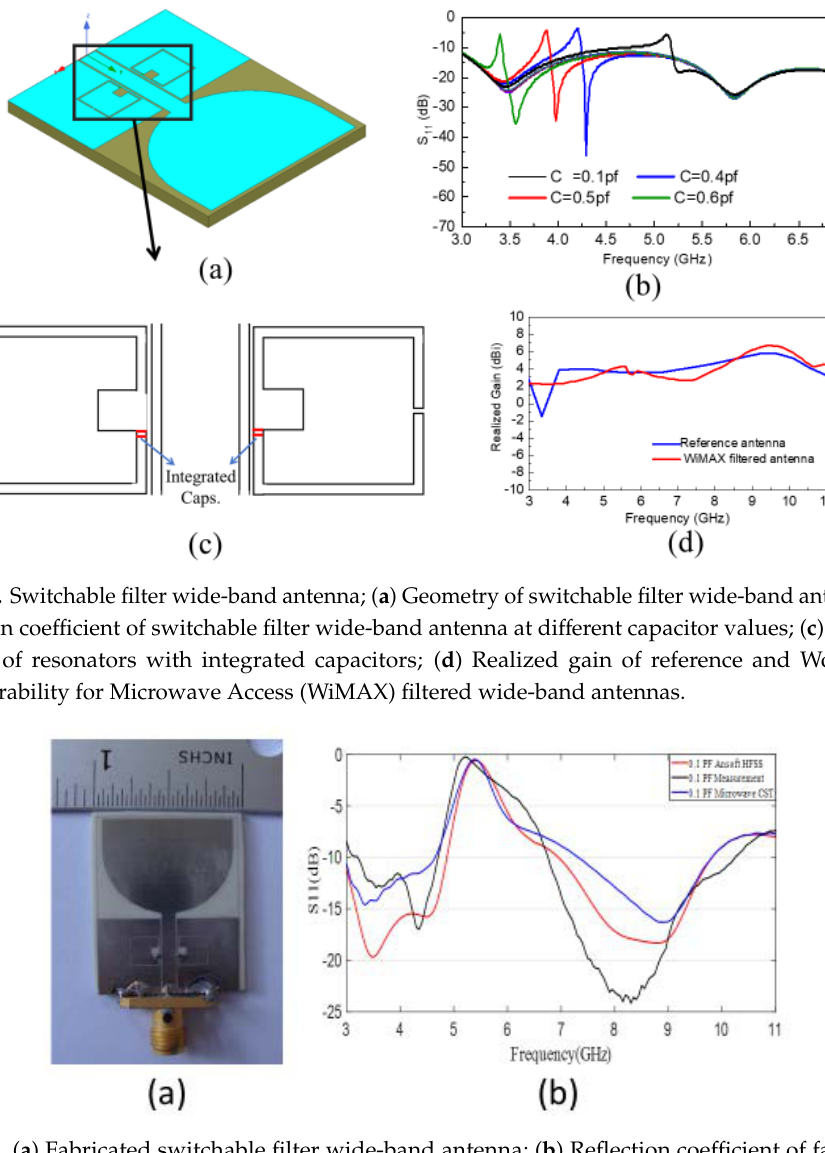
Figure 3. ( a ) Fabricated switchable filter wide-band antenna; ( b ) Reflection coefficient of fabricated switchable filter wide-band antenna with a filter at Wireless Local Area Network (WLAN) range.